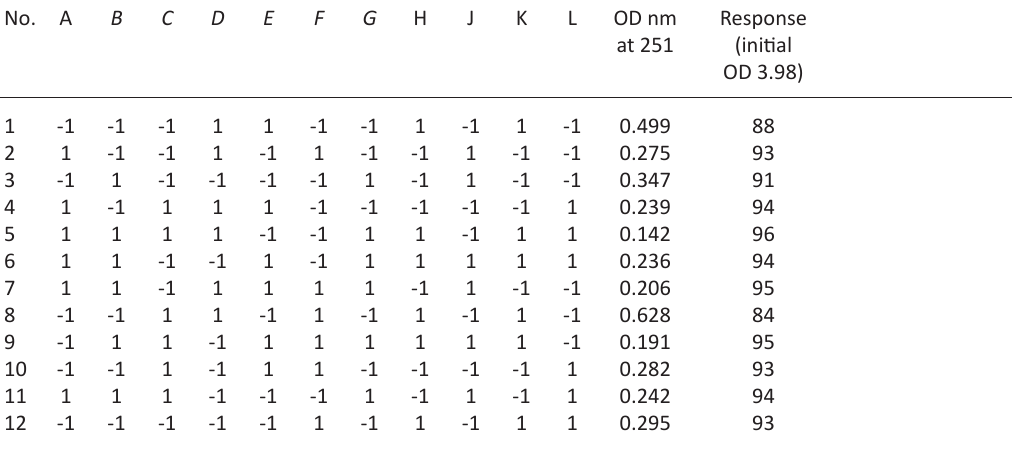
Table 4. The Plackett-Burman design with BTXP degradation as the response No. A